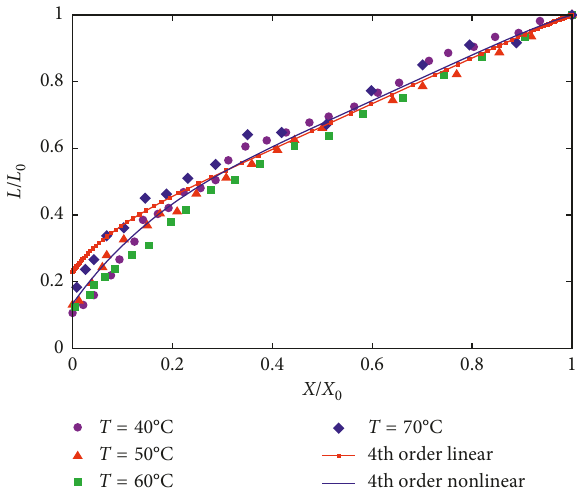
Figure 4: Comparison between experimental data for L / L X / X 0 for chayote discoid samples and the 1-d moving boundary model predictions obtained with the two different models for α shown in Figure 5(b). The red dotted curve shows model prediction with the α function adopting the linear approximation X / X 0 (equation (13)). The blue curve shows model predictions with the α function adopting the nonlinear approximation equations (28) and (29). The thickness calibration curve adopted is G 4th (equation (16)) and Bi m (cid:31)